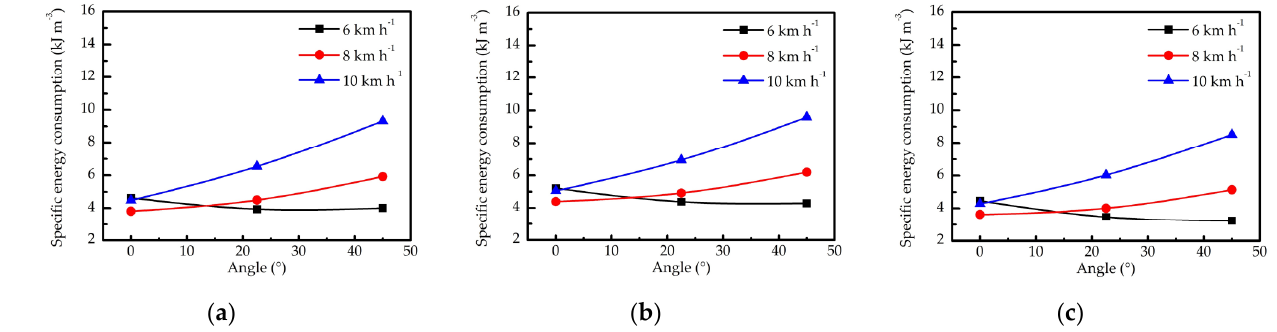
Figure 9. Relationship between specific energy consumption and penetration angle, operating depth and operating speed: ( a ) Relationship between penetration angle, operating speed and specific energy consumption at the operating depth of 60 mm; ( b ) relationship between penetration angle, operating speed and specific energy consumption at the operating depth of 70 mm; ( c ) relationship between penetration angle, operating speed and specific energy consumption at the operating depth of 80 mm.